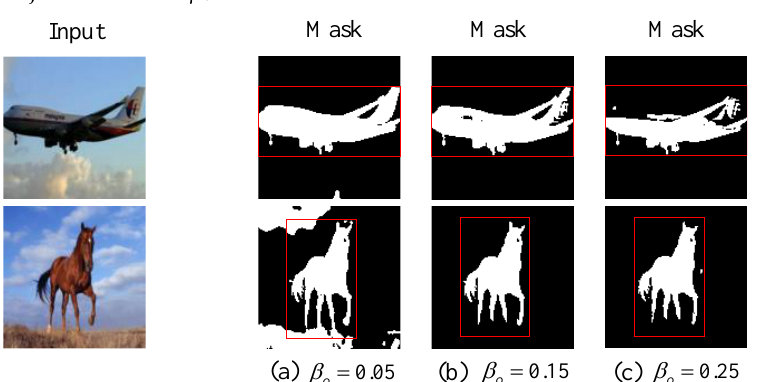
Figure 5. The experimental results of different β o for the object loss. Appropriate β o eliminates the information outside the red boxes and ensures the clear boundary of the object.